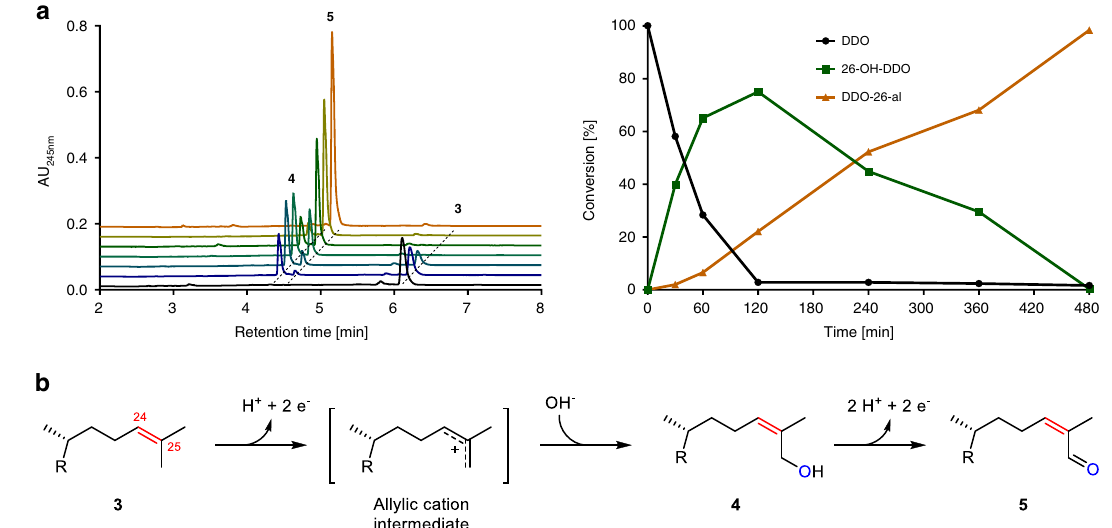
Fig. 3 Oxygen-independent conversion of desmost-1,4-dien-3-one (3). a Conversion of DDO to the two products 4 and 5 in soluble extracts of S. denitri fi cans . b Reactions sequence obtained via a proposed allylic cation intermediate after NMR-based identi fi cation of products as 26-OH-DDO 4 and the corresponding C26-aldehyde DDO-26-al 5 . The enzyme involved was identi fi ed as a Mo-dependent hydroxylase. Source data are provided as a Source Data fi